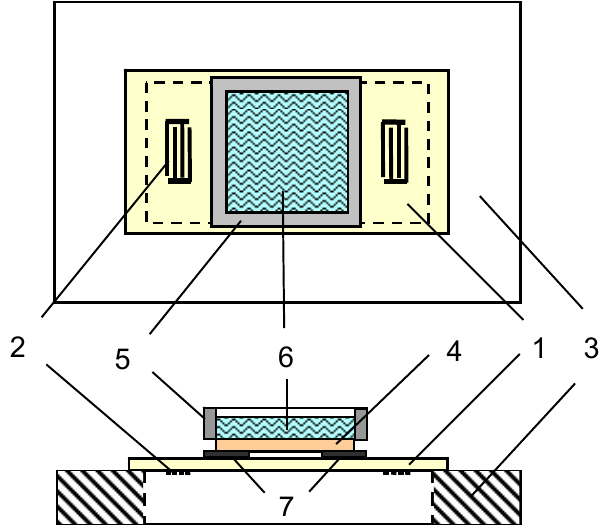
Figure 3. The scheme of the acoustic slot wave sensor: 1: piezoelectric plate of Y-X LiNbO 3 , 2: IDTs, 3: the holder of the plexiglass, 4:piezoelectric plate of Z-X+30 ◦ LiNbO 3 , 5:liquid container,6:suspension of the cells under study, 7: the strips of the aluminum foil.